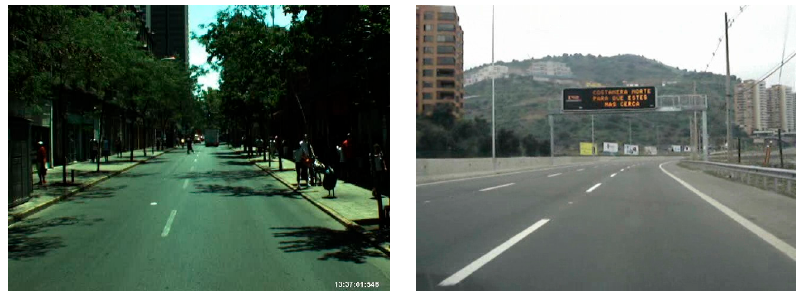
Figure 15. Examples of images on Santiago Lanes Dataset (SLD) datasets.